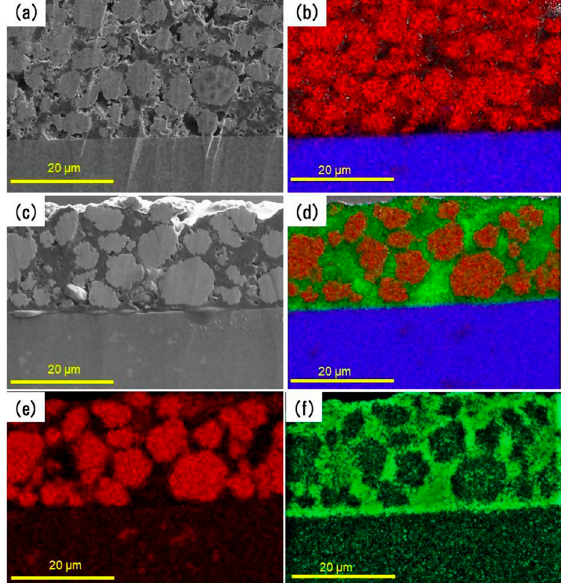
Figure 2. SEM and EDX-mapping images of the sectional view of the NMC cathode. ( a , b ) are with no ionogels (control sample) and ( c , d ) are with ionogel respectively. Red, green and blue colors indicate cobalt (NMC), sulphur (ionogels) and aluminum (current collector), respectively. ( e , f ) are EDX-mapping images of cobalt and sulphur extracted from ( d ). Reprinted with permission from Ogawa et al.